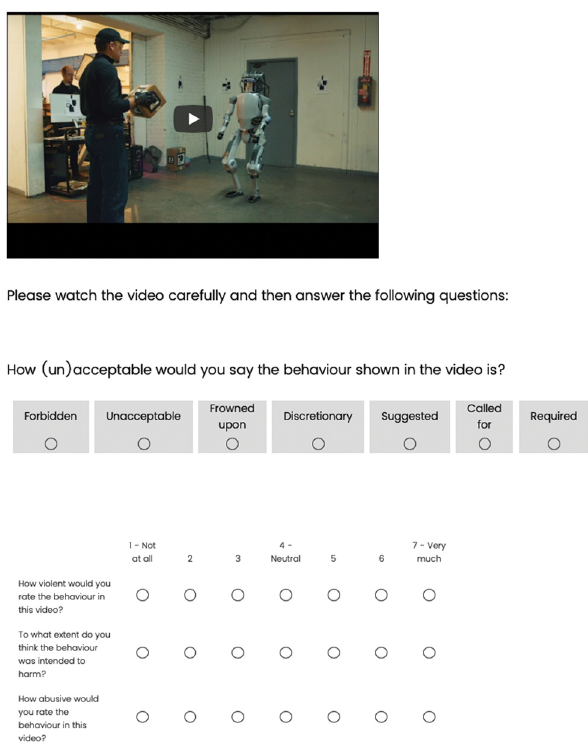
Figure 2: Screenshot of one of the videos plus the